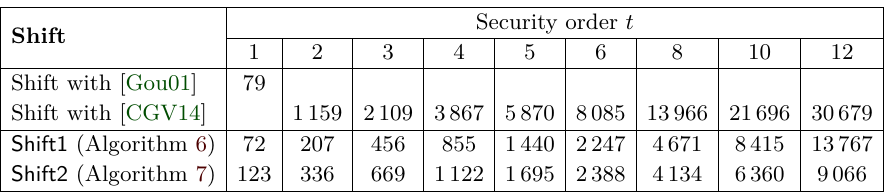
Table 5: Operation count for arithmetic shift with k = 13 bit input and a shift by ‘ = 3 bits, computed as a sequence of ‘ shifts of 1 bit for our table-based countermeasure, with n = t + 1